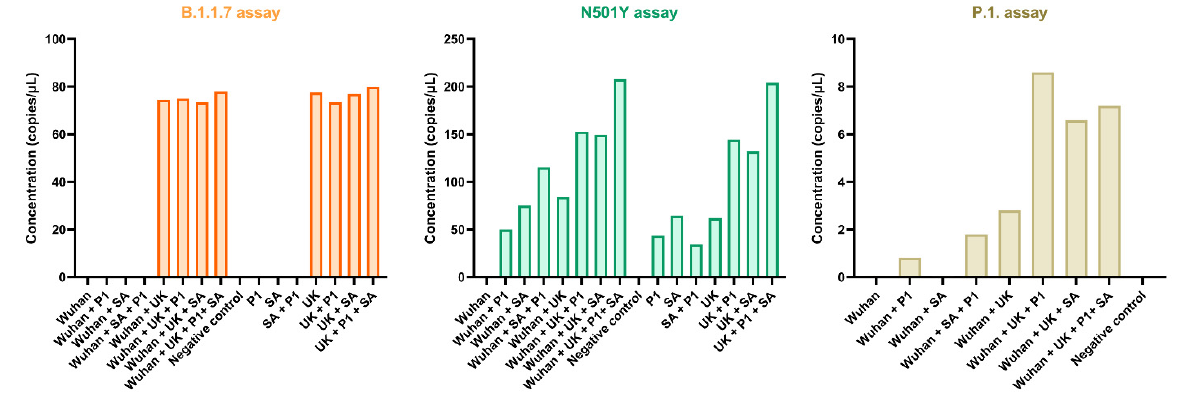
Figure 3. Specificity of the B.1.1.7 (orange), the N501Y (green) and P.1. (brown) assay to reaction mixtures ( x -axis) containing different combinations of variants of concern RNA with digital PCR.